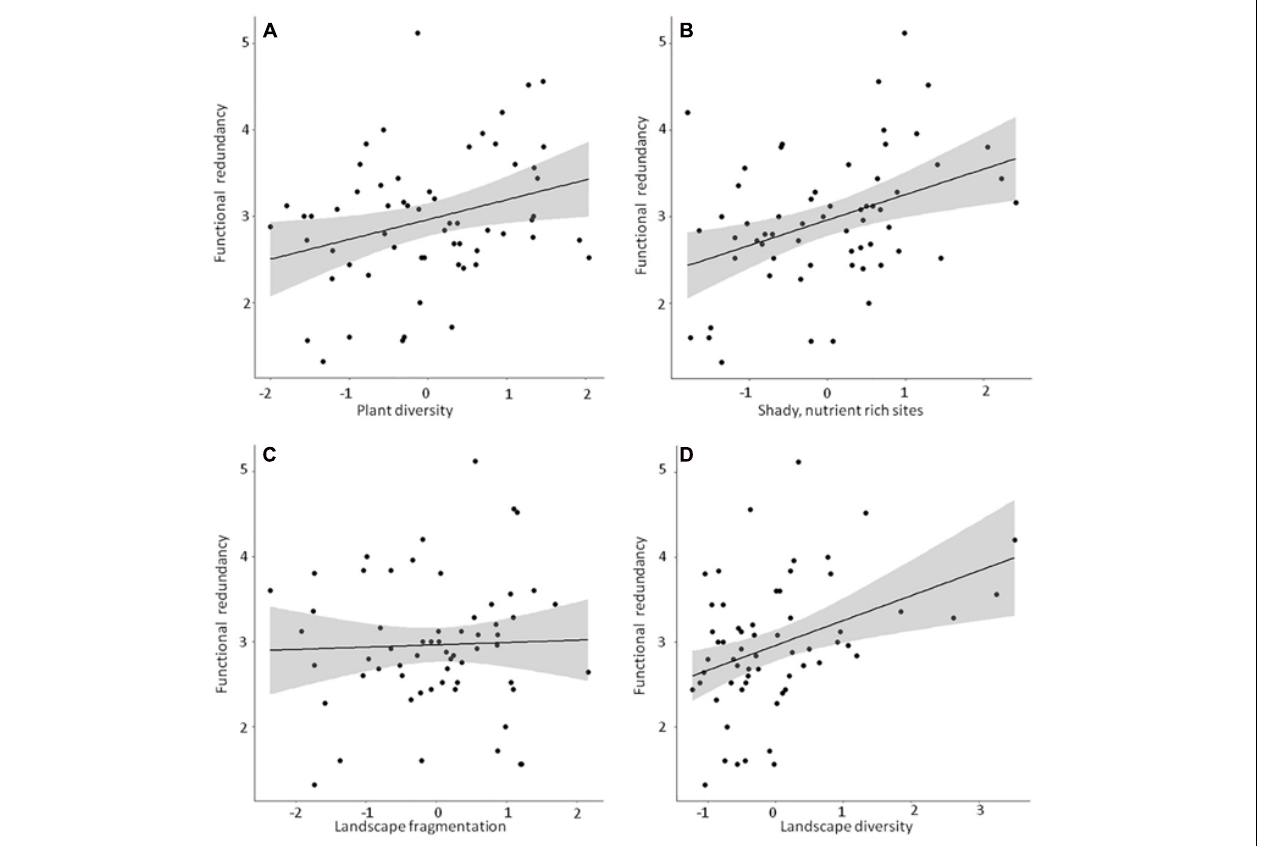
FIGURE 5 | Linear bivariate regressions showing the relationships between functional redundancy and (A) Plant diversity, (B) Shady, humid, nutrient rich sites, (C) Landscape fragmentation and (D) Landscape diversity. Detailed results of the linear mixed effects models (shown as black line and shaded area) can be looked up in Supplementary Table 4